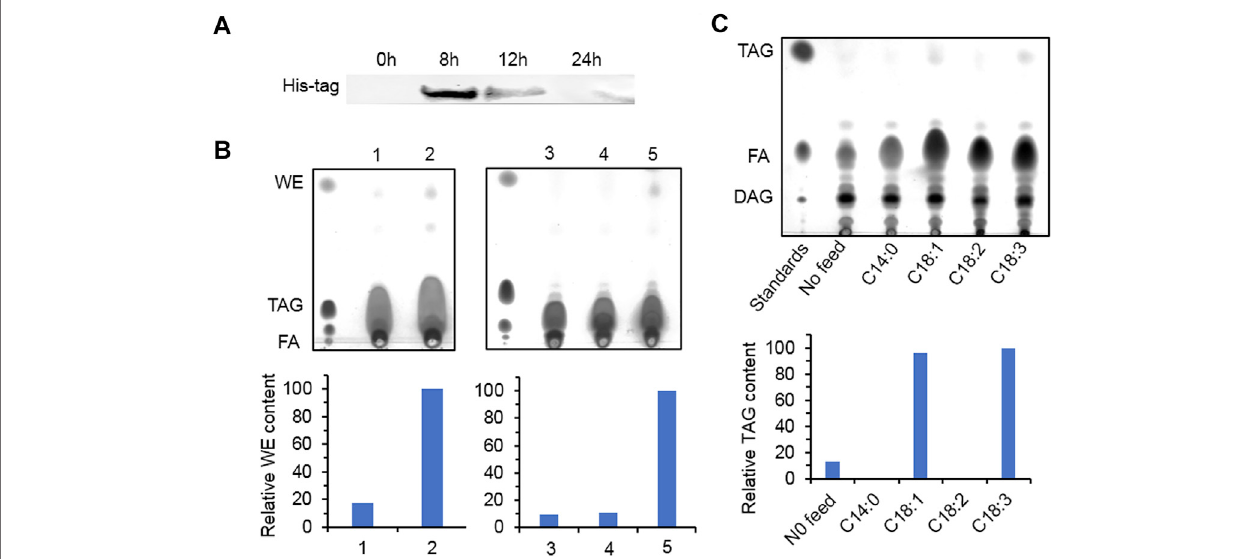
FIGURE2| FunctionalstudyofHpWSinthe Saccharomycescerevisiae H1246 system. (A) ExpressionofrecombinantHpWSinyeastmicrosomesafter induction forupto24 hat25 ° C. (B) Thin-layerchromatography(TLC)separationofwaxestersproducedin S.cerevisiae harboringemptyvector(EV)(1)or HpWS (2)fedwith0.1% ( w / v )C16:0FA+C16alcohol+C18alcohol; S.cerevisiae harboring HpWS fedwith0.1%( w / v )C16:0FA(3),C16:0FA+C16alcohol(4),orC16:0FA+C18alcohol (5). (C) TLC separation of TAGs produced in S. cerevisiae harboring HpWS fed with 0.1% ( w / v ) four species of fatty acid. Relative contents of WE and TAG were quanti fi ed by ImageJ. FA, fatty acid; WE, wax ester; TAG, triacylglycerol; DAG,